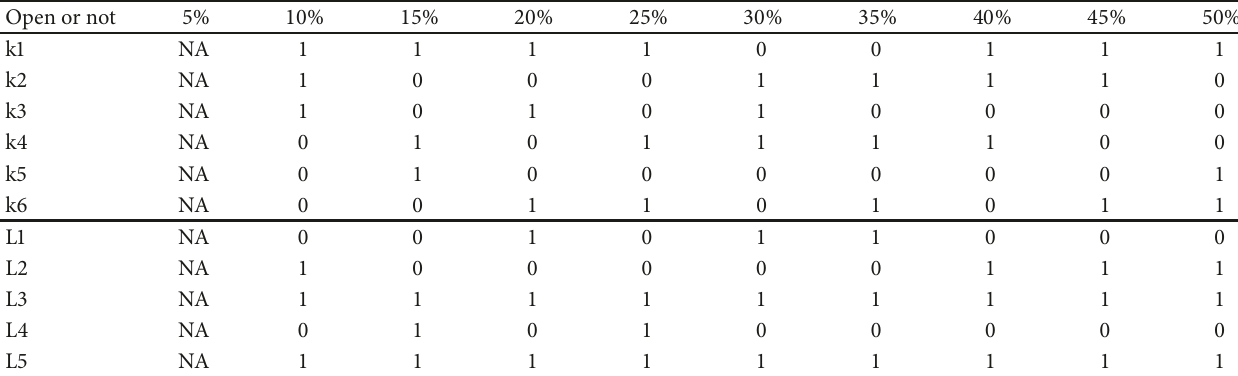
Table 16: Impact of processing cost coefficients’ variance on choice of opening sites.